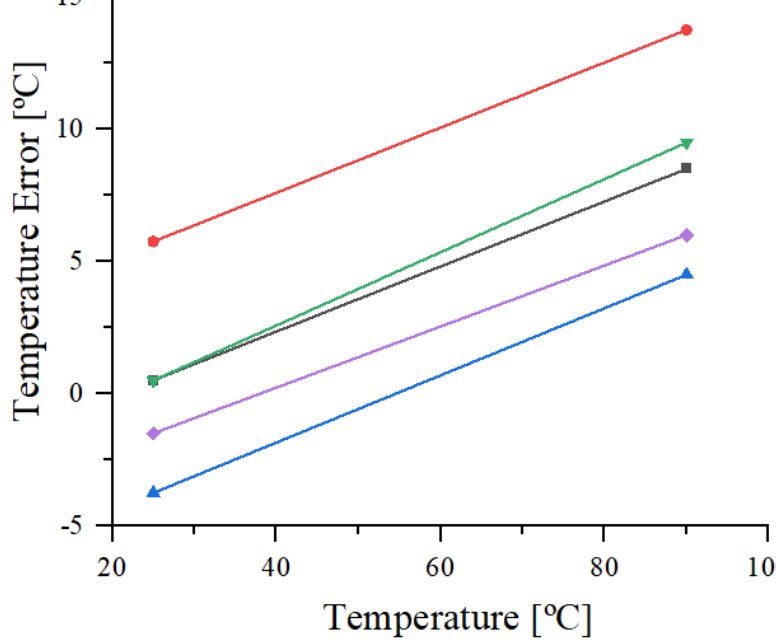
Figure 6. Measured temperature error of 5 untrimmed DTS samples at 1.8 V.